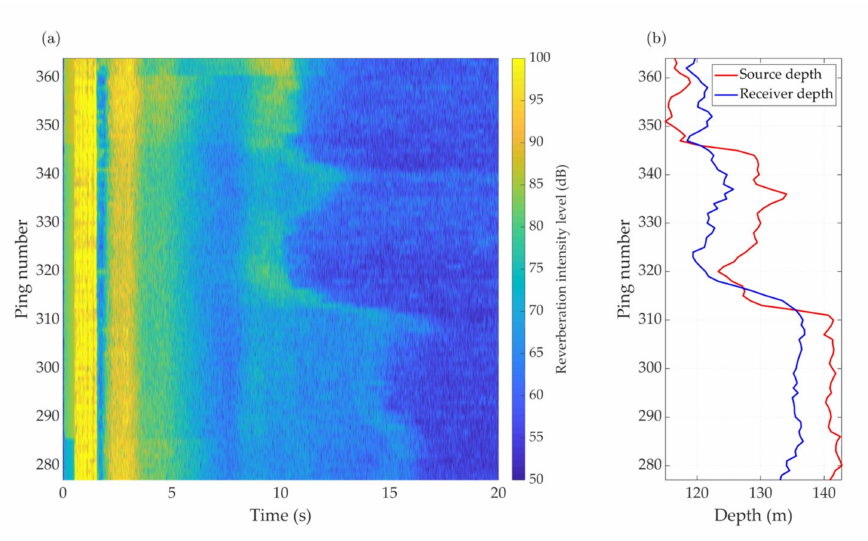
Figure 8. ( a ) Beam time series for the time and ping number from starboard direction. ( b ) Source and receiver depth corresponding to the ping